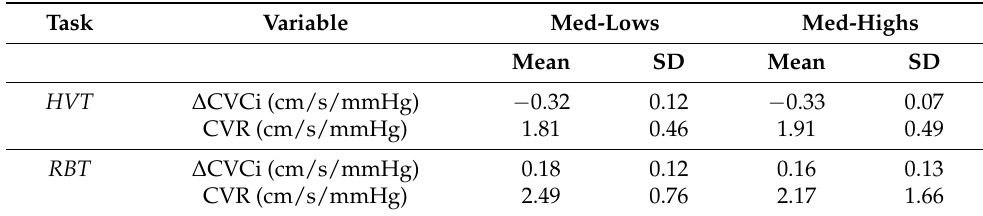
Table 2. Derived Doppler variables.